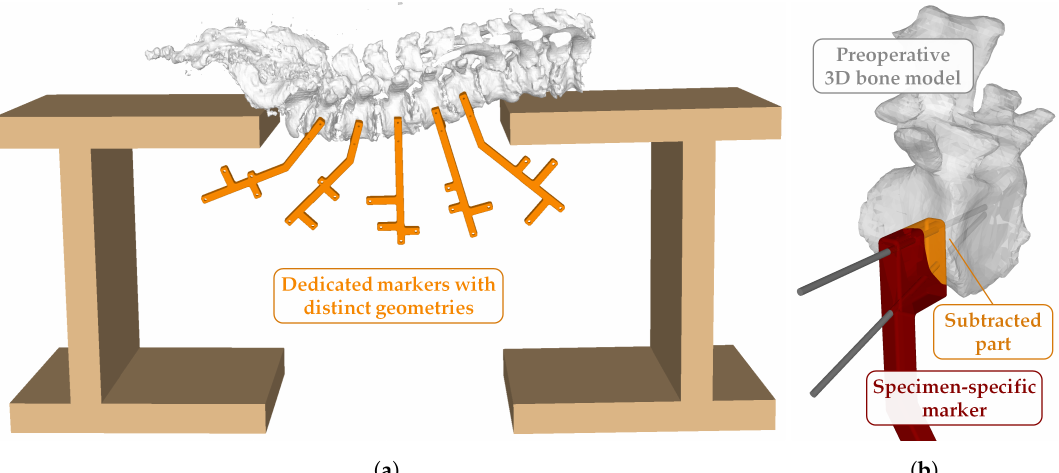
Figure 3. Setup for individual tracking of levels L1–L5. ( a ) Dedicated markers with distinct geometries (orange), designed and positioned such that they neither interfered with one another nor the C-shaped wooden jig. ( b ) Specimen-specific marker (red). The part for fixation was molded as a mirror model, such that it could fit to the vertebrae in an specific position and orientation. It was achieved by subtraction of the 3D vertebra model (white) from its corresponding marker 3D model (orange) using Boolean difference operation. Two slightly converging drill canals allowed for fixation through